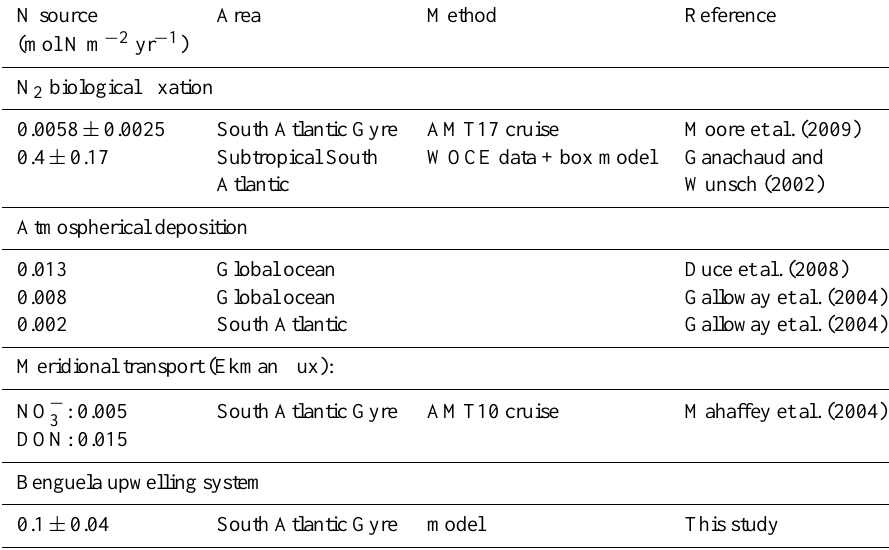
Table 2. N source estimates (molNm − 2 yr − 1 ) at regional and global